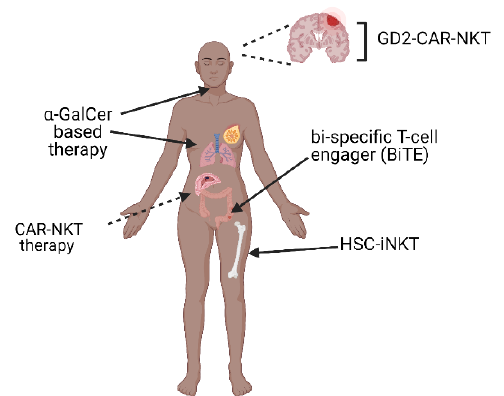
Figure 2. Targeting invariant natural killer T (iNKT) cells in solid tumors. Many strategies are being employed to harness the power of NKT cells in cancer immunotherapy. Treatment with α-GalCer-pulsed APC has been shown to result in antitumor immune responses, particularly in lung and head and neck cancers. Cell based therapeutics such as CAR-NKT and HSC-iNKT cells have shown efficacy in preclinical models. In addition, there are several reports investigating the direct modulation of NKT cells using BiTEs and α-GalCer-based therapy. Taken together, these studies demonstrate the feasibility of targeting NKT cells for cancer immunotherapy and present innovative strategies that can be employed to increase our understanding of this important population of T cells.